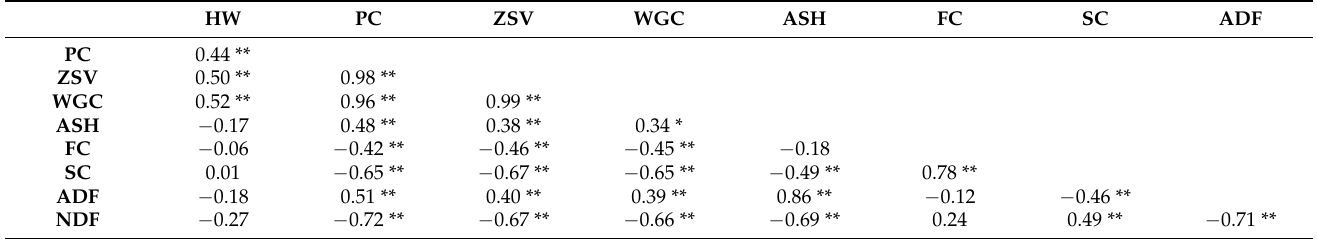
Table 7. Correlation coefficients between the features and significance